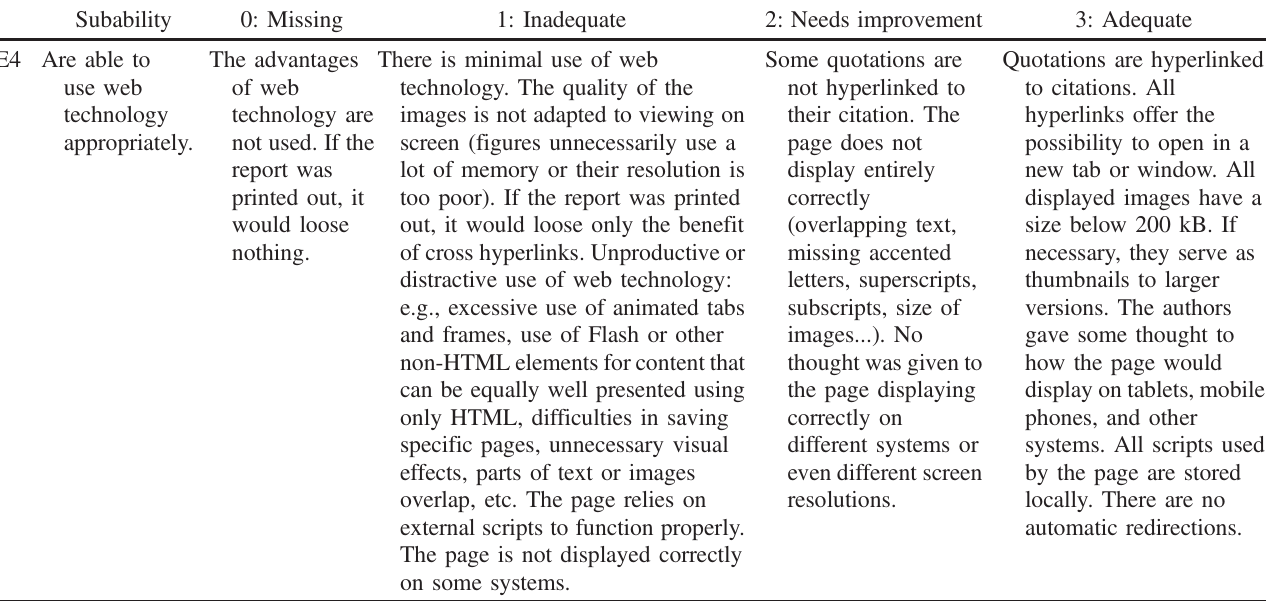
TABLE VII. The fifth line of the new rubric for the ability of writing a report in the form of a web page. Subability